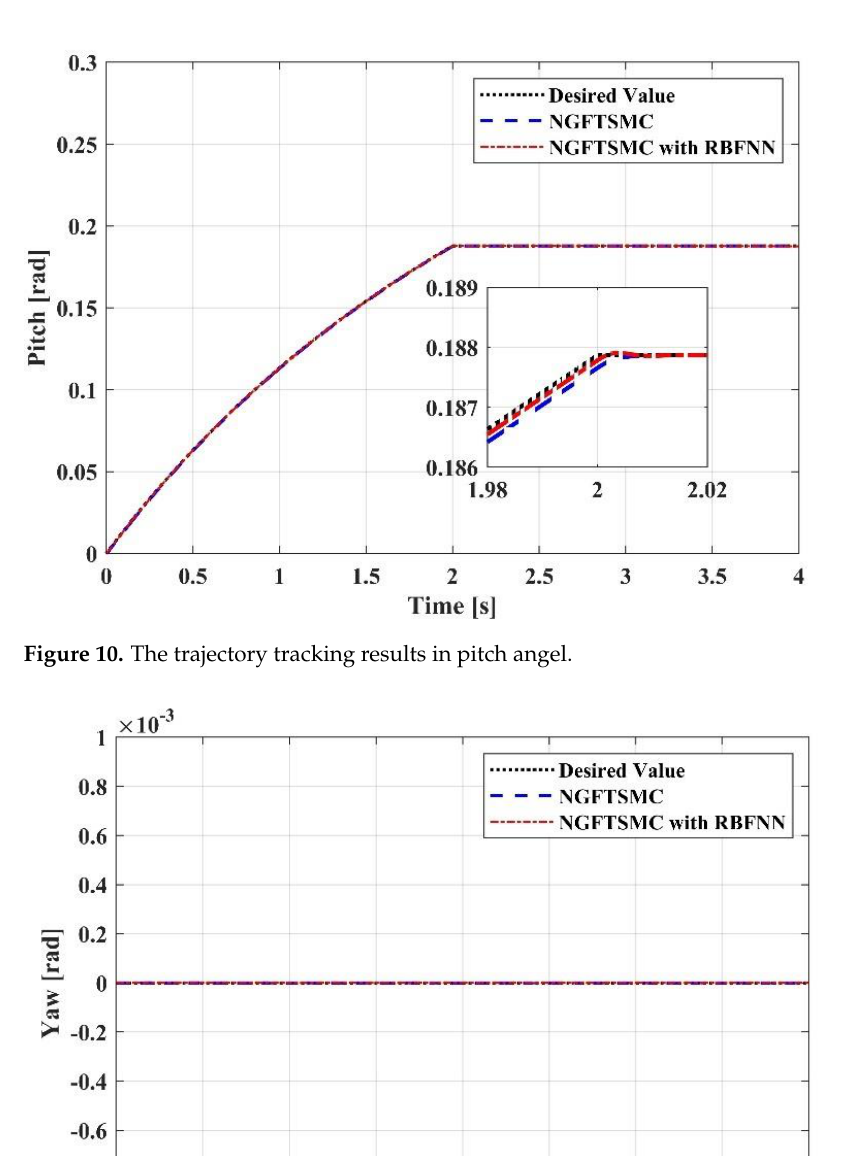
Figure 9. The trajectory tracking results in roll angel.